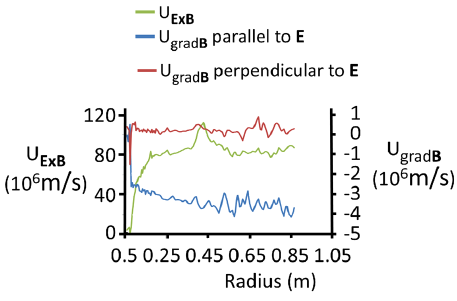
FIG. 27. Guiding center velocities for the bottom A-K gap.